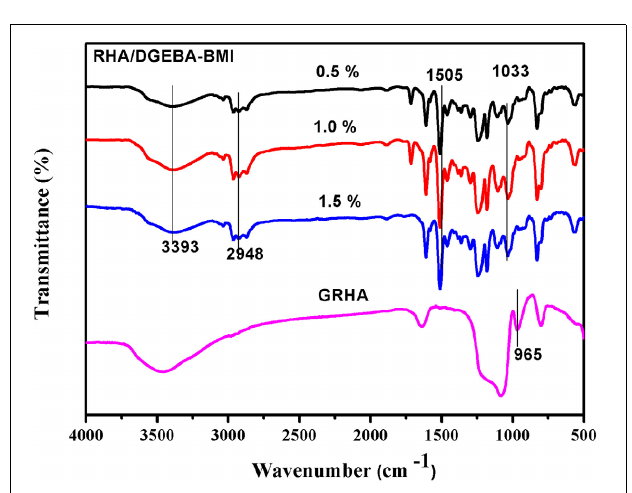
FIGURE 3 | FT-IR spectra of neat epoxy and epoxy-BMI.